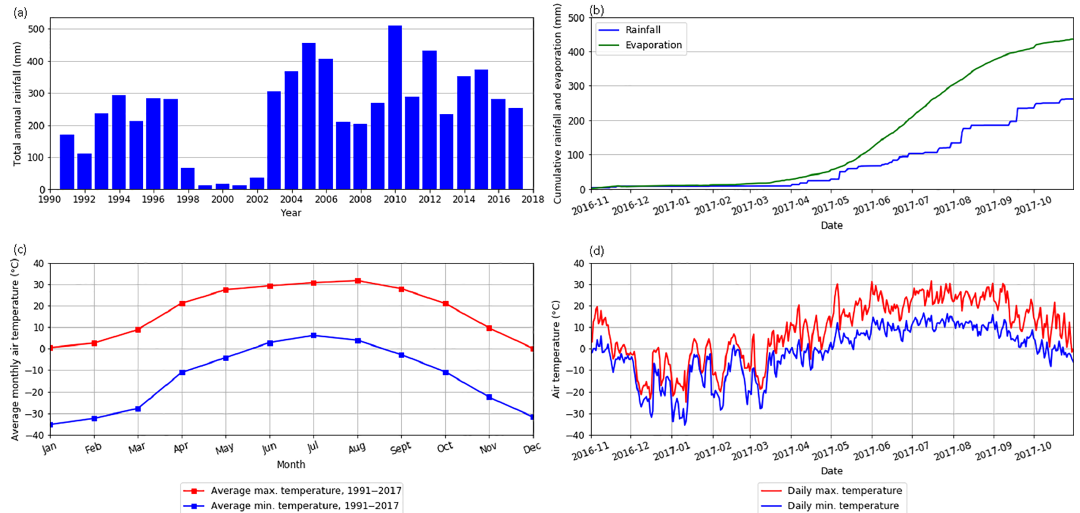
Figure 2. Meteorological data from SDNWA: (a) the total annual rainfall for the period of record (1991–2017) measured at the mast tower; (b) cumulative total rainfall (mast tower) and evaporation (scaffold tower) for the 2016–2017 hydrologic year; (c) mean monthly air temperature at 2m (mast tower) for the period of record (1991–2017); and (d) daily air temperature at 2m (mast tower) for the 2016–2017 hydrologic year.